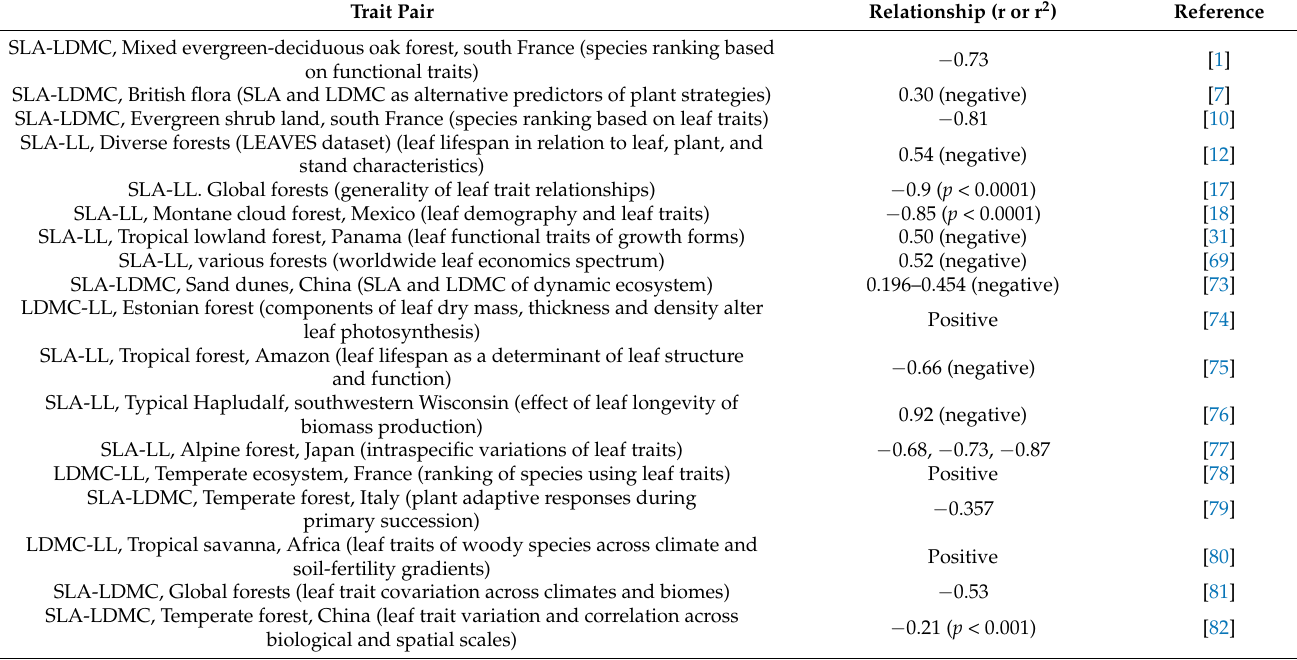
Table 3. Correlation between leaf traits recorded from forest types around world. Trait